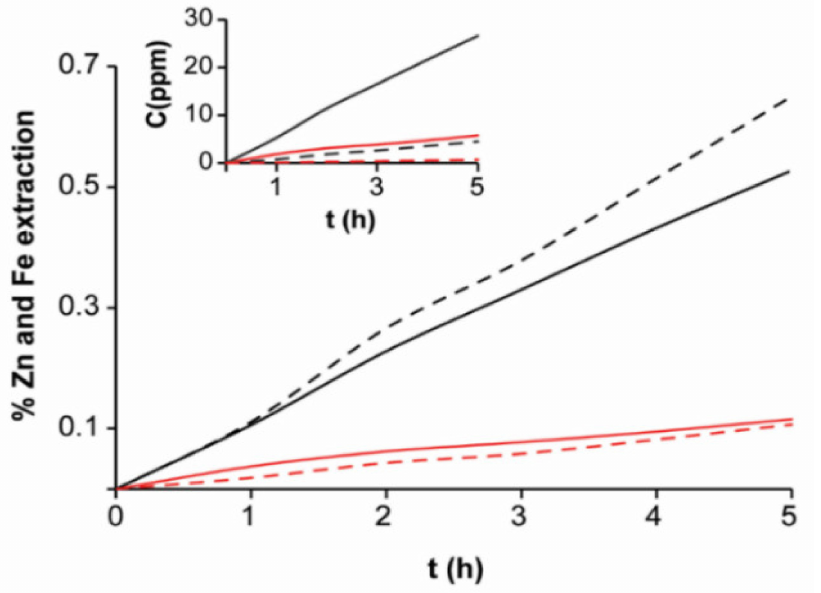
Figure 10. Percentage of extracted zinc and iron related to the initial sphalerite sample concentration (Zn, 5 g; Fe, 0.7 g) at 25 ◦ C. Red lines show the extraction at pH = 7; black lines, at pH = 2. Full lines represent Zn; dashed lines, Fe. The inserted plot indicates the concentration changes of zinc ions and ferrous ions.